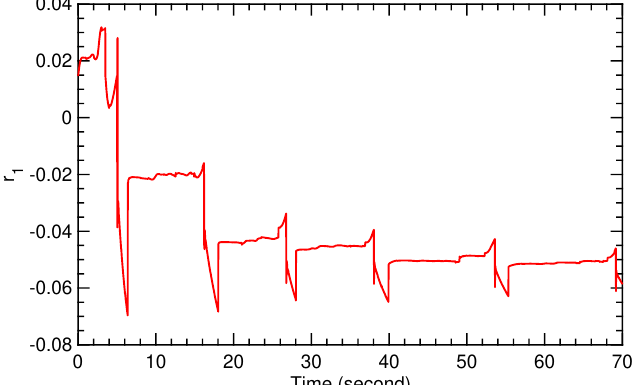
Figure 22. Time history of controller parameter r 1 for flight condition II.